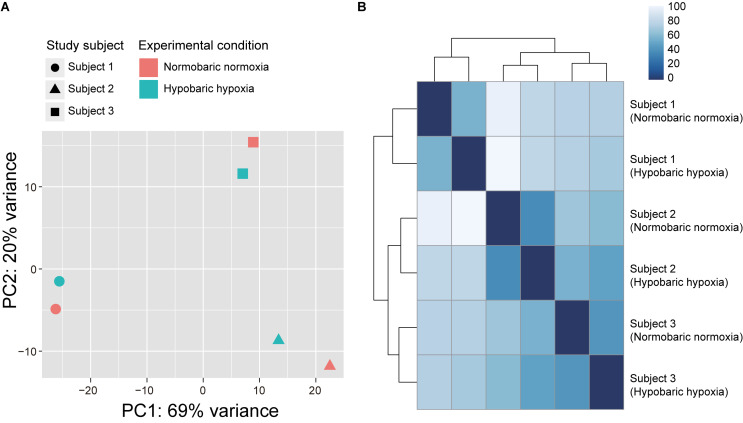
Transcriptome similarity among samples from three Japanese subjects participating in the acute hypobaric hypoxic experiments. (A) Principal component analysis of RNA-seq data plotted according to the first (horizontal axis) and second (vertical axis) principal components. (B) Heatmap of Euclidean distance between the expression vectors. The Euclidean distance was calculated using the R dist function.